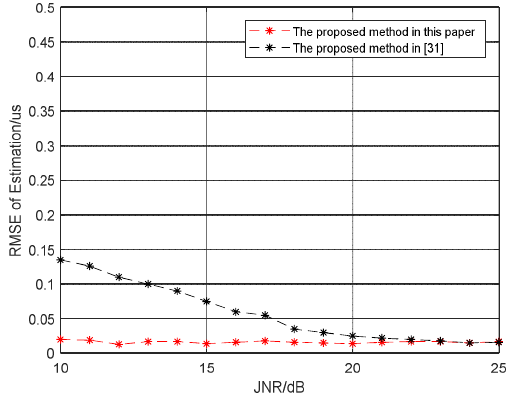
Figure 5. RMSE of slice width estimation.